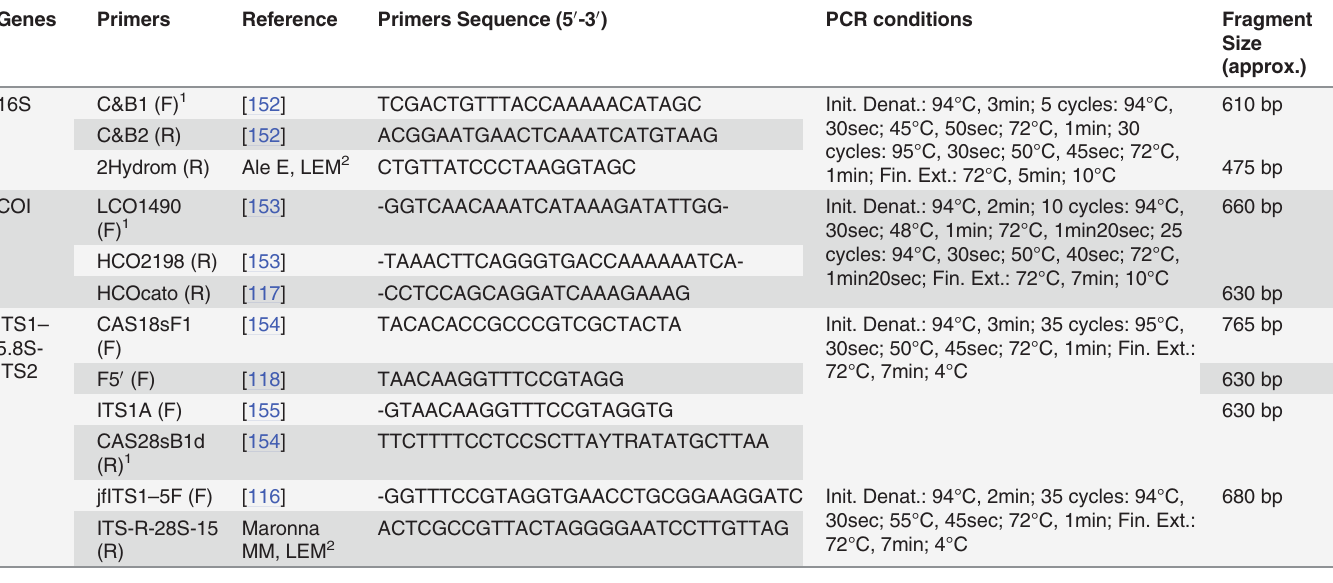
Table 3. Primers and PCR conditions for DNA ampli fi